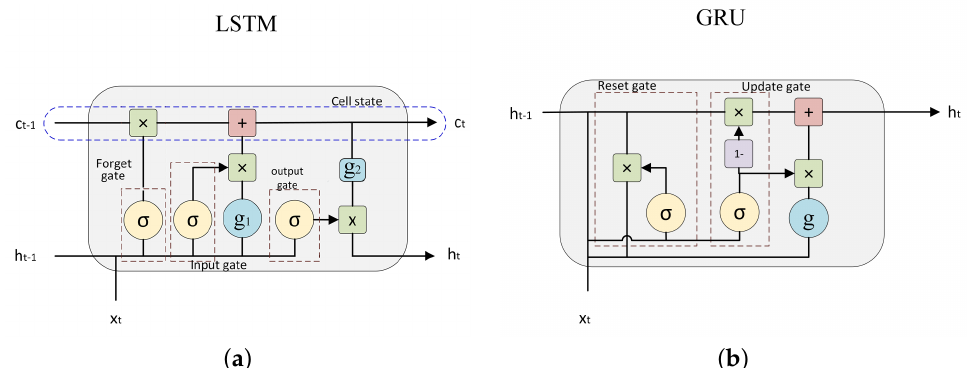
Figure 3. Long Short-Term Memory (LSTM) ( a ) and Gated Recurrent Units (GRU) ( b )